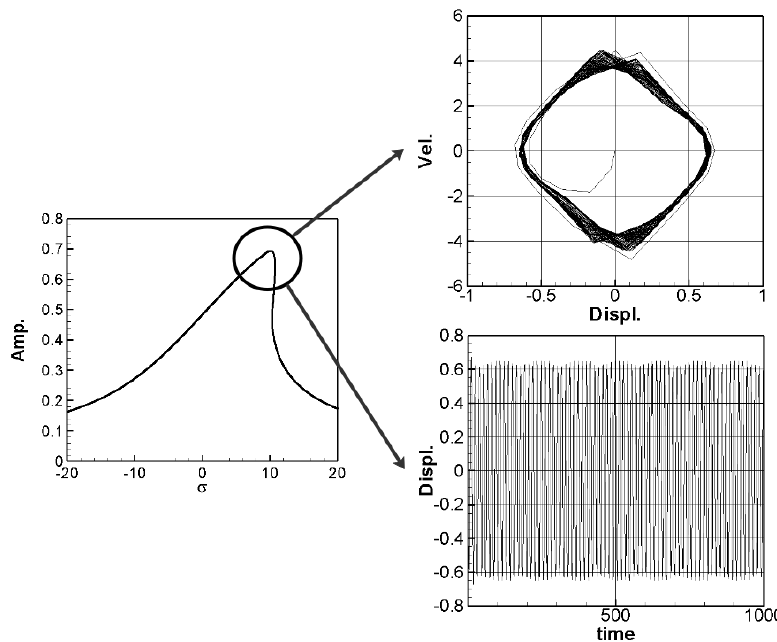
Figure 10. DES verification diagrams of fixed-point plots, phase plots, and time response plots of the 1st mode’s forced response.